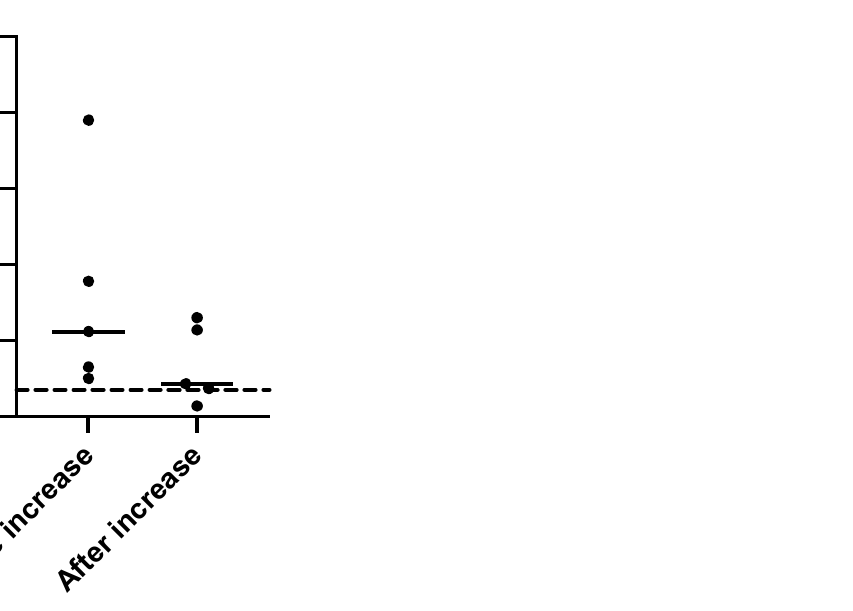
Figure 3. Comparison of serum Spec fPL concentrations before dose increase and at follow-up in 5/19 cats with presumed chronic pancreatitis treated with cyclosporine. Short horizontal lines represent median, long horizontal stippled line represents the upper limit of the serum Spec fPL reference interval (3.5 μ g/L).